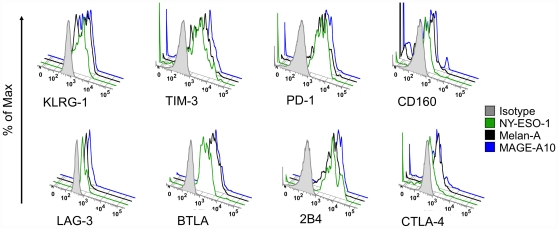
Expression of inhibitory receptors on self/tumor-specific T-cells.Expression of inhibitory receptors by Melan-A, NY-ESO-1 and MAGE-A10-specific T-cells from a representative patient (LAU 1169). CD8 T-cells were enriched using magnetic bead sorting. Melan-A- (black), NY-ESO-1- (green) and MAGE-A10- (blue) specific CD8 T-cells were identified by tetramer staining as described in the Materials and Methods section. An isotype control (grey) is shown as reference.